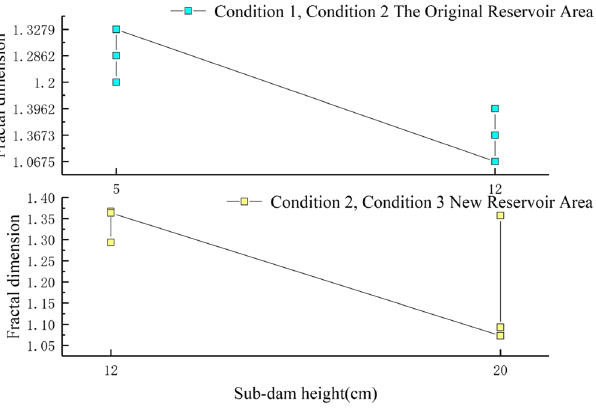
Figure 7. Fractal dimension of new and original reservoir fractures under three working conditions.